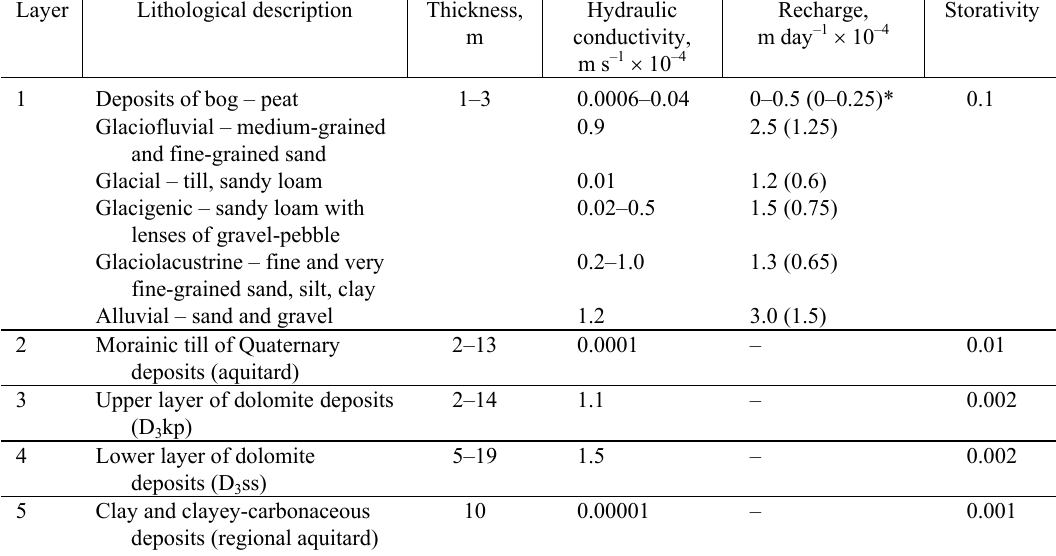
Table 4. Hydrogeological parameters selected for different deposits of the Č edasai model case